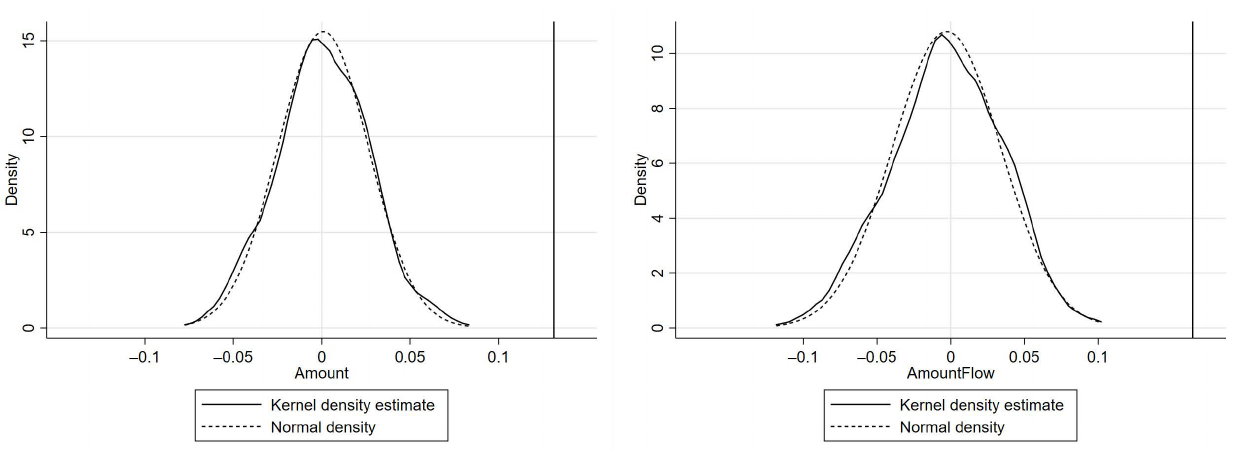
Figure 2. Placebo